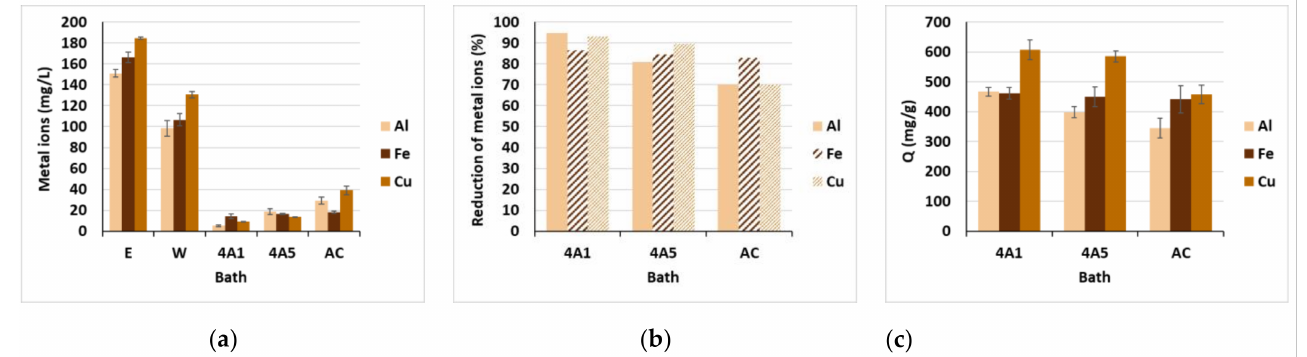
Figure 7. ( a ) Metal ions in baths in mg/L; ( b ) reduction in metallic ions in %; and ( c ) the amount of adsorbed metallic ions per weight of adsorbent (Q) in mg/g.